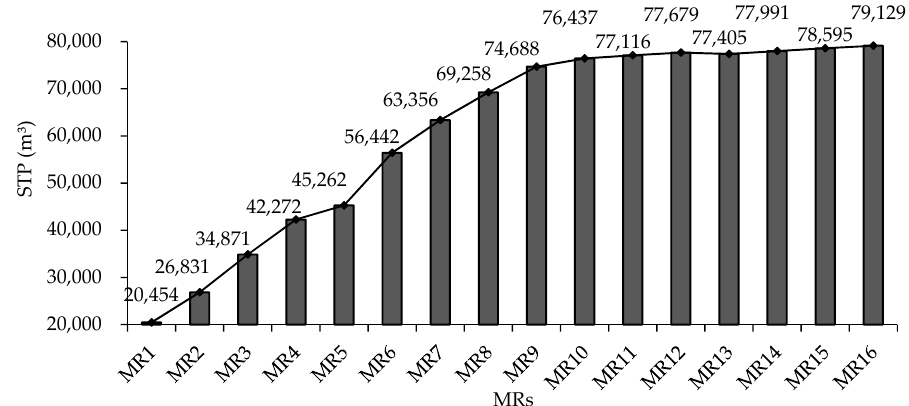
Figure 2. Variance of STP with harvesting intensity in sixteen MRs.